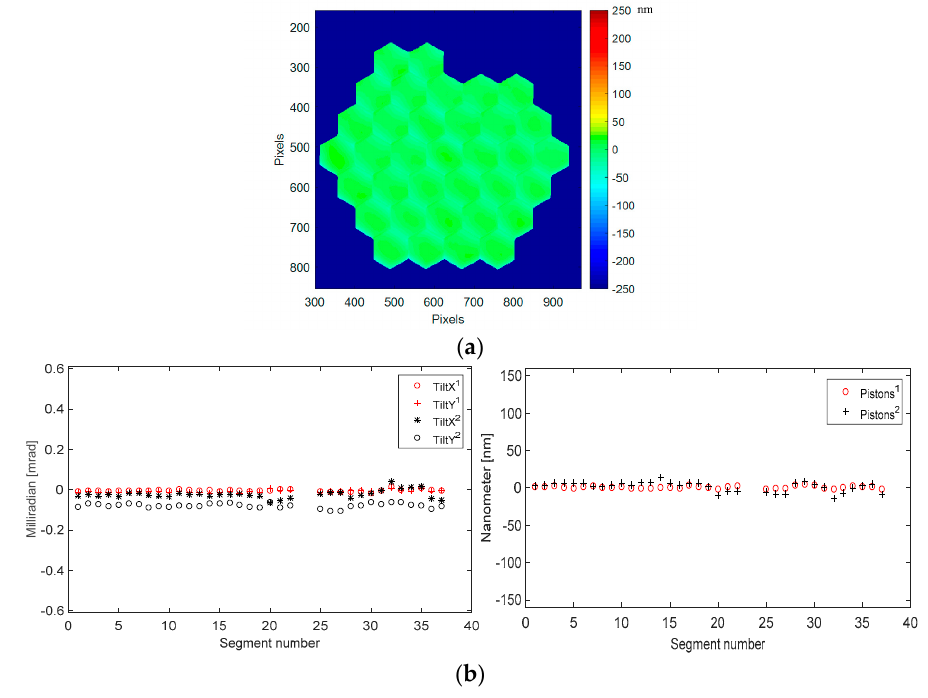
Figure 14. Mirror surface deformation at ambient (293 K) when improved best flat condition is applied, after one cycle of cooling: ( a ) Surface deformation map (10 nm RMS, 79 nm PtV); ( b ) Residual tilts and pistons values for each of the 37 segments of PTT111. Residual tilts with improved best flat (red signs) are 6.5 µrad RMS (36 µrad PtV), while they were 32 µrad RMS (140 µrad PTV) with the original best flat (black signs). Residual pistons with improved best flat (red signs) are 1.6 nm RMS (7 nm PtV), while they were 6.2 nm RMS (28 nm PtV) with the original best flat (black signs).